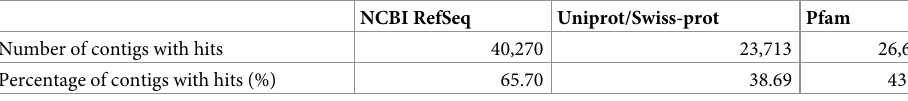
Table 2. Number and percentage of significant hits against biological relevant databases.